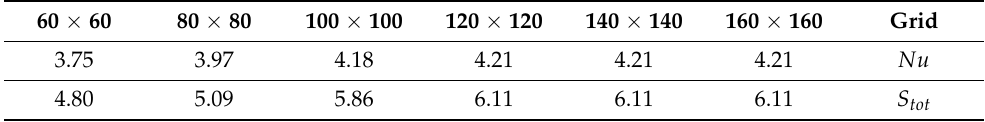
Table 4. Evaluating the effect of the number of grid points on the studied parameters.